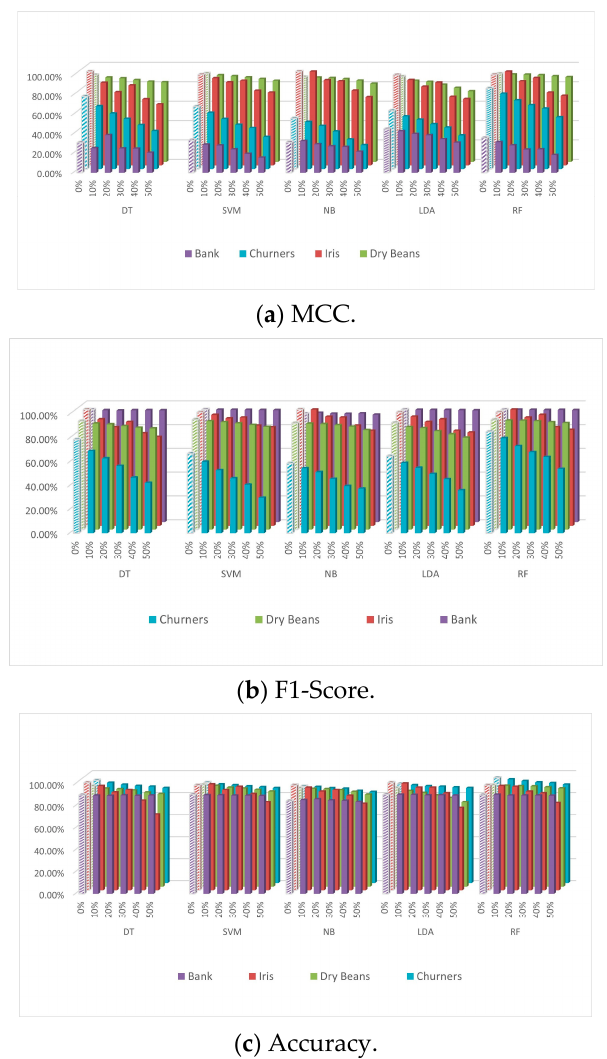
Figure 3. Performance of the five classifiers on the six datasets with different ratios of MCAR MVs imputed using